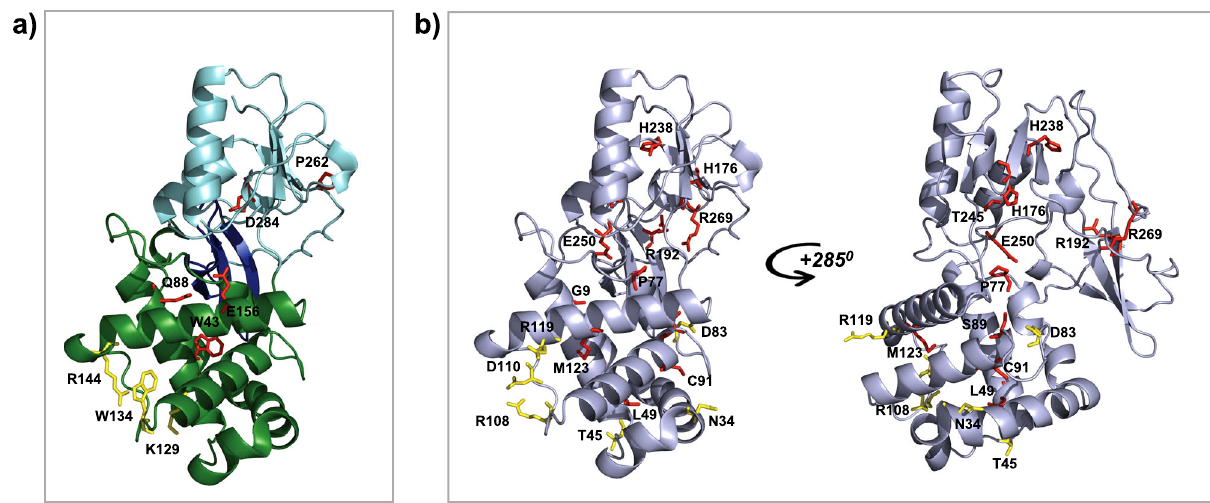
Fig. 3 Deleterious mutations. a Cartoon representation of the X-ray crystal structure of the N-terminal module of BF155 with residues labelled in red for the structurally damaging mutations, and in yellow for mutations predicted to affect functionally important residues. b Mutations in BAF170 shown on a cartoon representation of a homology model with residues highlighted as in panel ( a ).